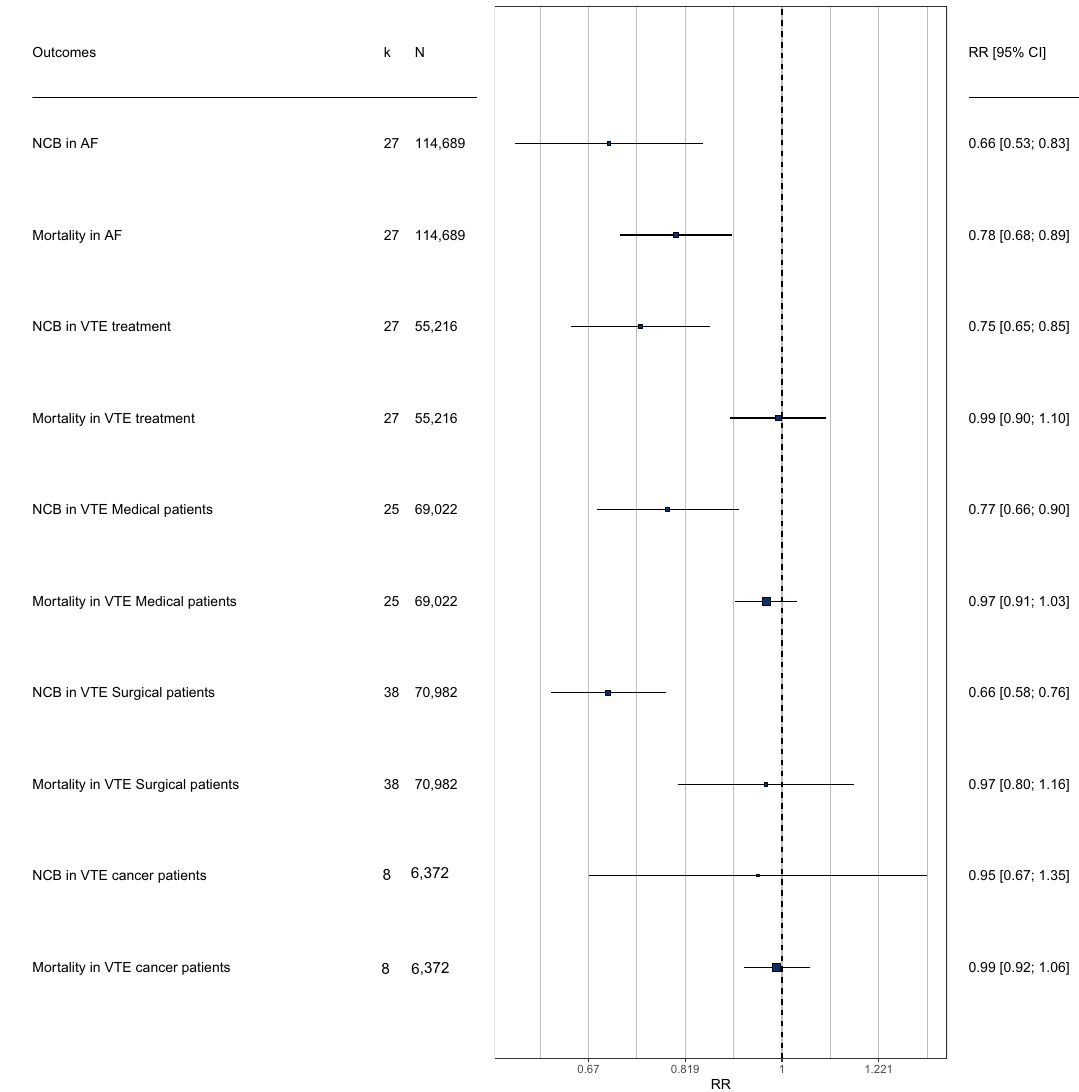
Figure 2. Summary of the meta-analysis and forest plot for all indications. Forest plot of treatment effects on all-cause mortality and net clinical benefit (NCB). The horizontal error bars show the 95% confidence interval (CI) of each relative risk (RR) based on the random-effect model. The square represents the RR. An RR of < 1 favors the experimental group, an RR = 1 indicates no difference in treatment effects, and an RR of > 1 indicates a harmful effect of the control group. AF = Atrial fibrillation, K = number of studies for each indication, MB = Major bleeding, N = Total number of the included patients, VTE = Venous